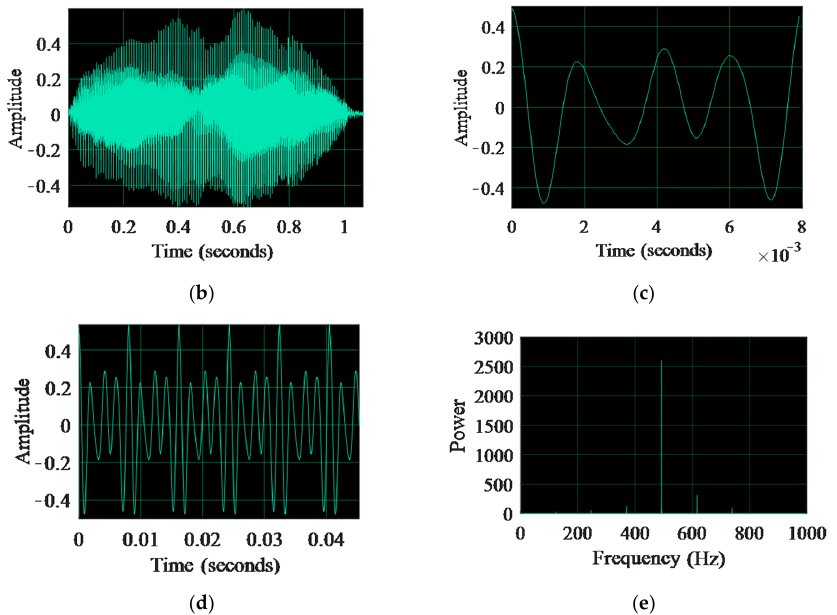
Figure 1. Speech feature extraction. ( a ) Original voice. ( b ) Step1: Single-syllable audio; ( c ) Step2: Single waveform of single-syllable audio; ( d ) Step3: Repetitive synthetic audio of a single waveform; ( e ) Step4: DFT conversion of a single waveform repeatedly synthesized for three seconds of audio.